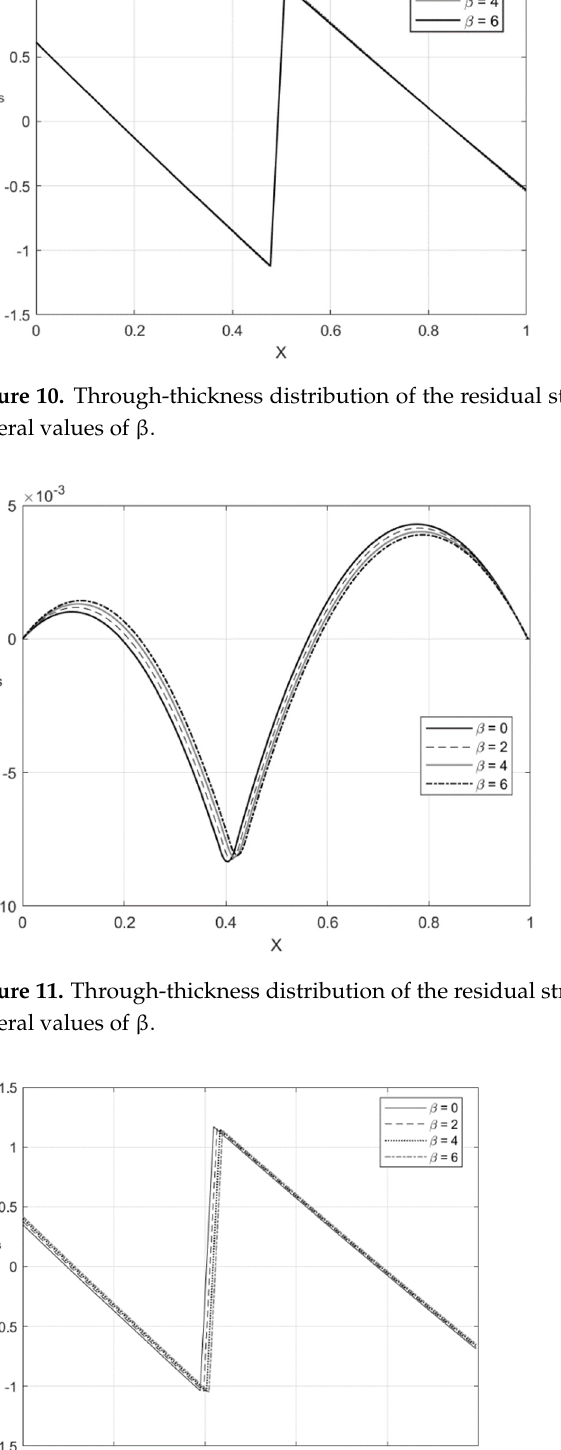
σ 0.06 H r = res at , η CD